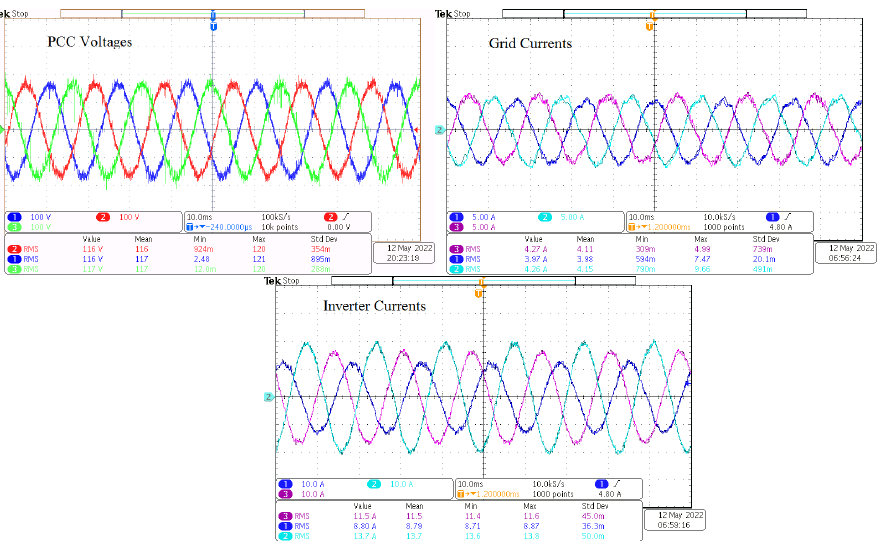
Figure 16. Experimental results at P = − 1 kW, Q = 500 var, using dSPACE Control desk.